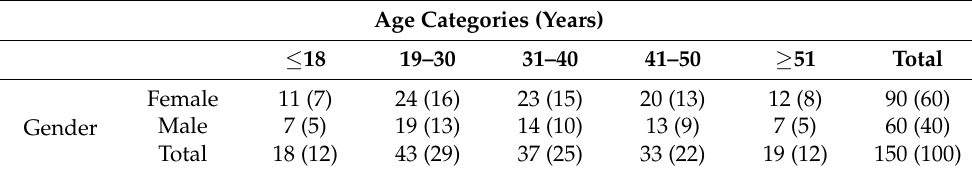
Table 1. Respondents’ gender and age